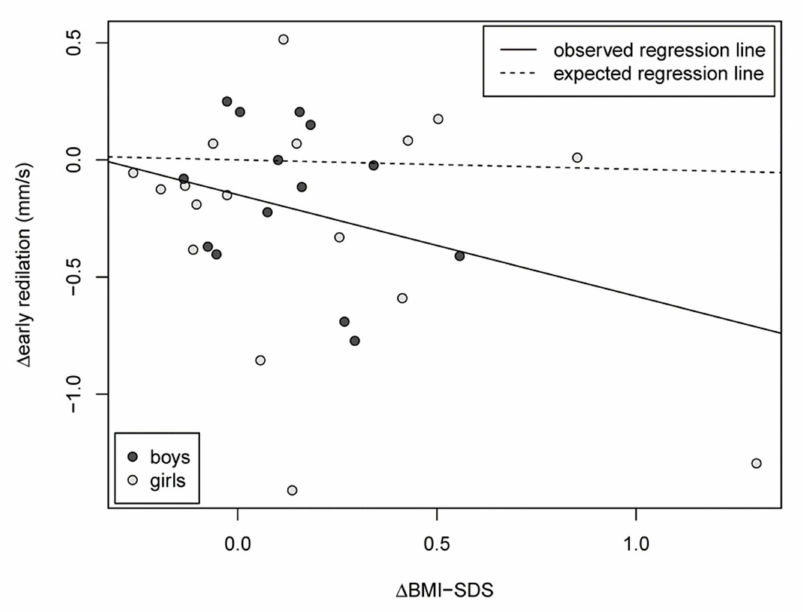
Figure 4. Associations between changes in BMI-SDS and changes in early re-dilatation velocity in in quantitative pupillography taken as a parameter for autonomic sympathetic dysfunction. BMI—body mass index; SDS—standard deviation score